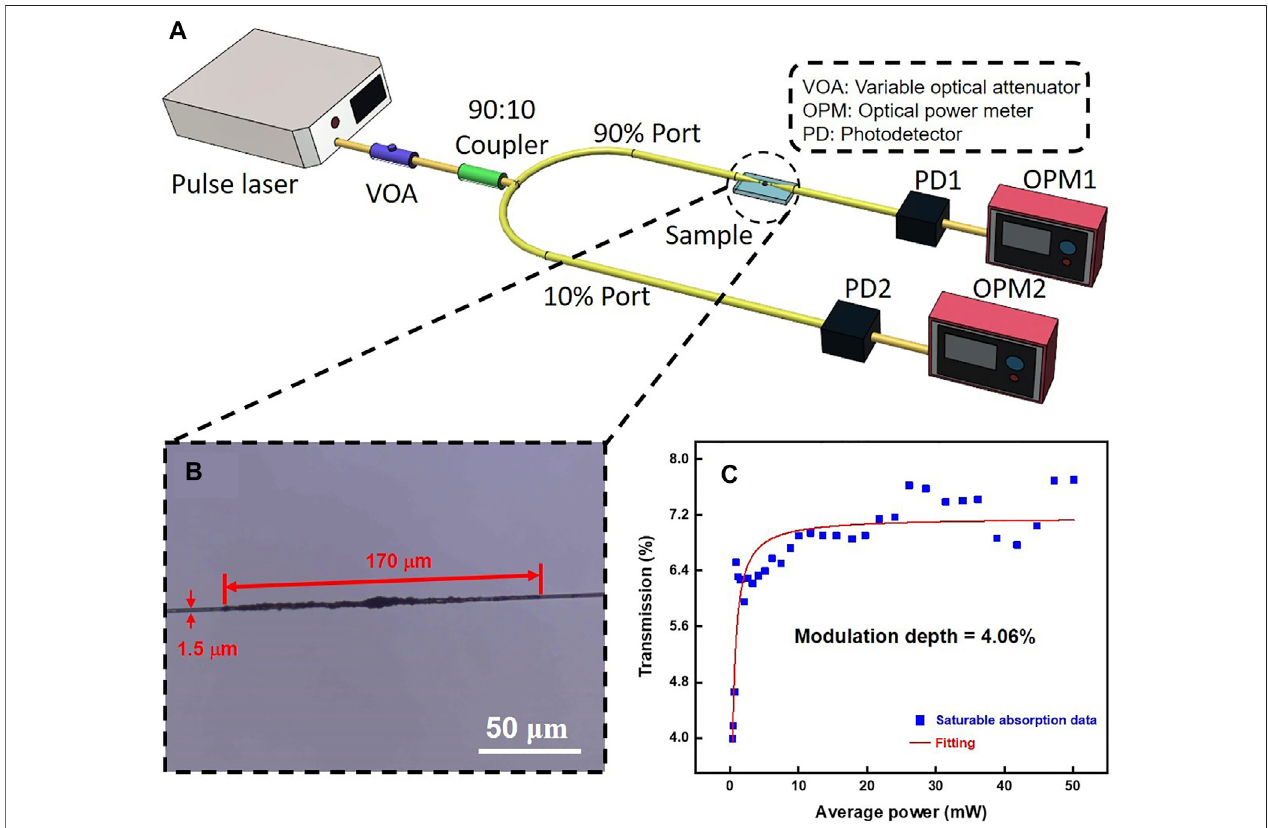
FIGURE3|(A) SketchdiagramofthemeasurementsystemforGDY-coatedmicro fi berSAeffect, (B) opticalmicroscopeimageoftheGDY-coatedmicro fi ber,and (C) saturated absorption characteristic curve of the GDY-coated micro fi ber.